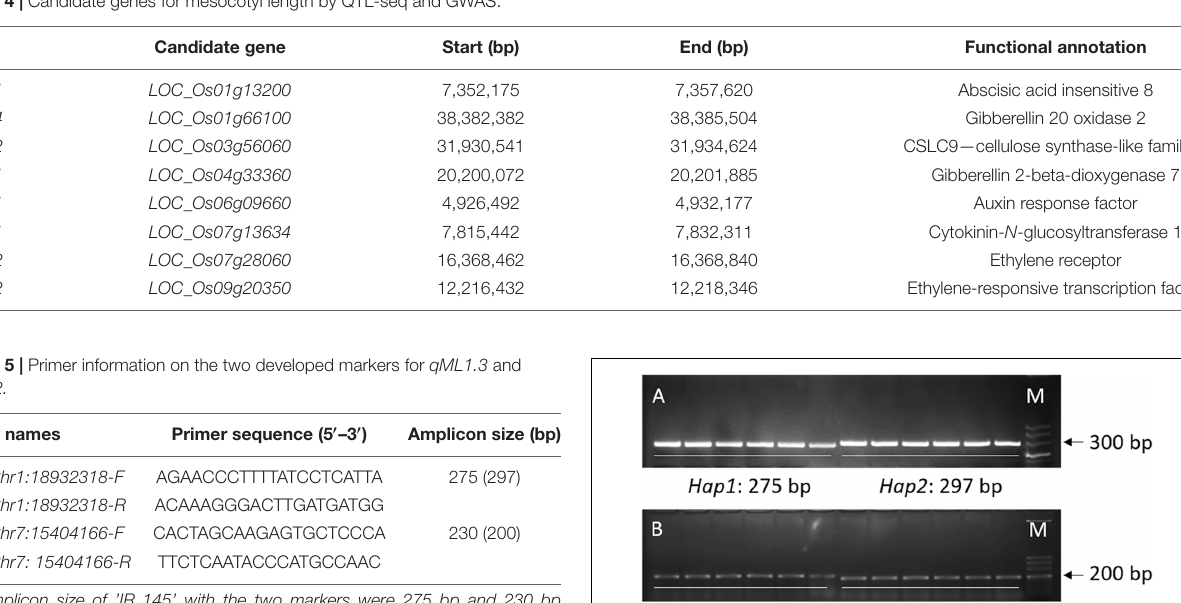
FIGURE 7 | Expression difference of the candidate genes for mesocotyl elongation by qRT-PCR. The X -axis represents the two parents of the F 2 population, whereas the Y -axis represents the relative expression of each gene to β -actin in mesocotyl tissue. Relative transcription levels were calculated by the 2 – (cid:49)(cid:49) CT method. Significance at ∗ P ≤ 0.05 and ∗∗ P ≤ 0.01. TABLE 4 | Candidate genes for mesocotyl length by QTL-seq and GWAS.